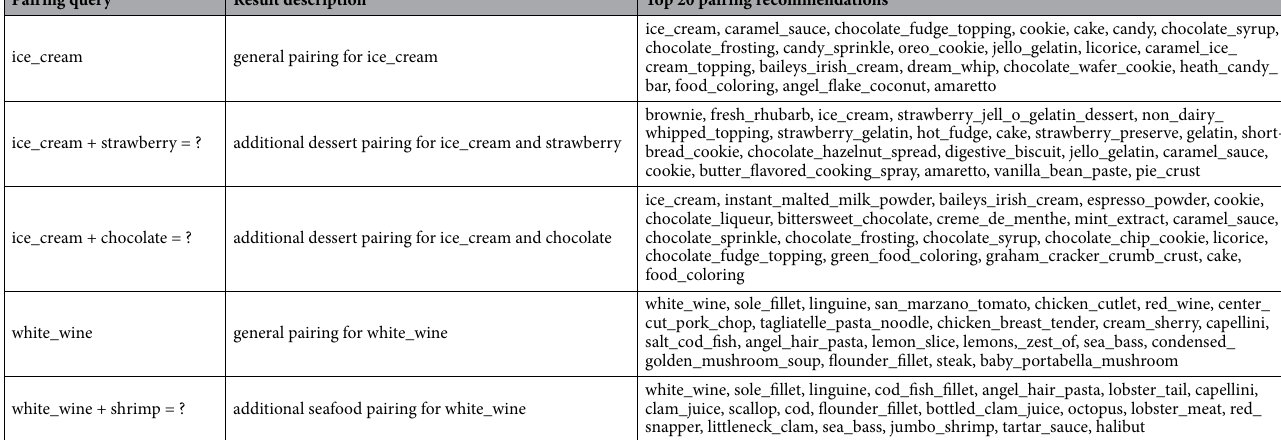
Table 5. Pairing recommendations for various food ingredients using simple vector